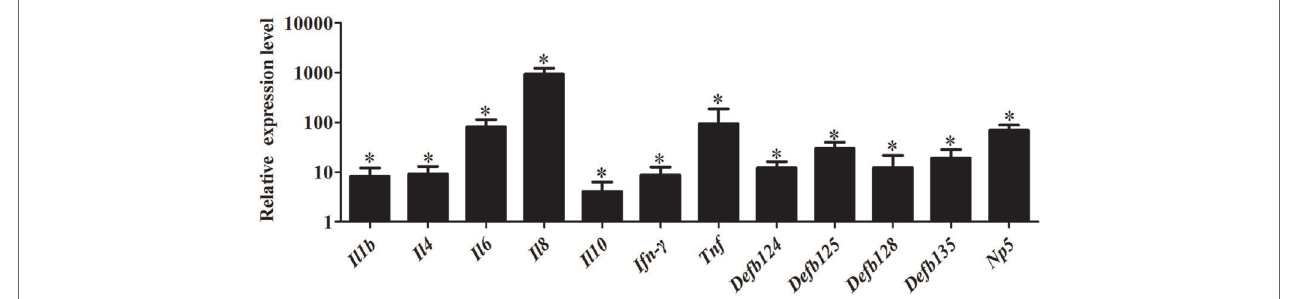
FigUre 8 | Effect of iE-DAP on expression of immune-related genes induced by Escherichia coli . RK-13 cells were treated with1 μ g/mL of iE-DAP for 12 h and then were infected with E. coli . M ± SD from three independent experiments are presented. Significant differences are indicated by